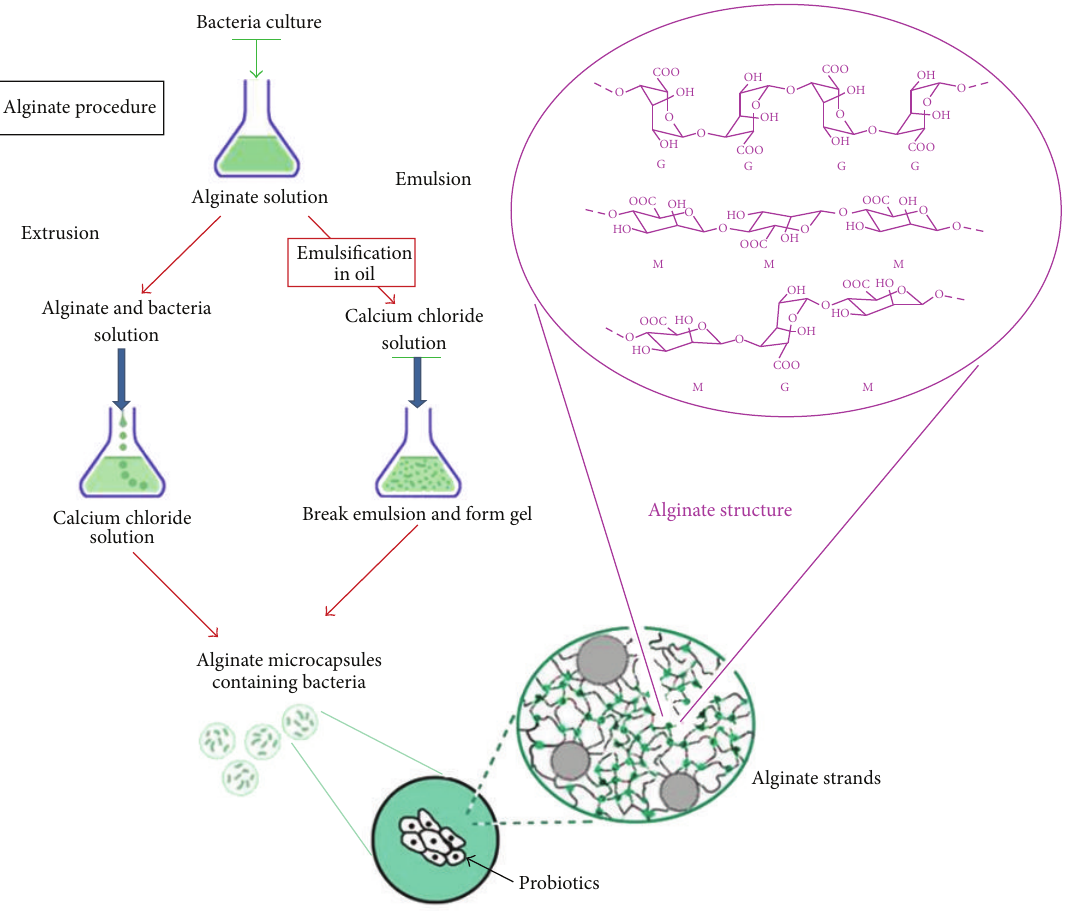
Figure 2: Steps of extrusion and emulsion processes and the chemical structure of the alginate residues along with a schematic diagram of the microorganisms and the